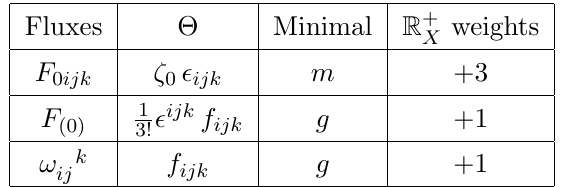
Table 3 . The embedding tensor/(cid:13)uxes dictionary specifying the massive IIA origin of Romans’ theory in 6d. The (cid:2) notation refers to the theory coupled to four vector multiplets in appendix C. ! ijk refers to the spin connection of S 3